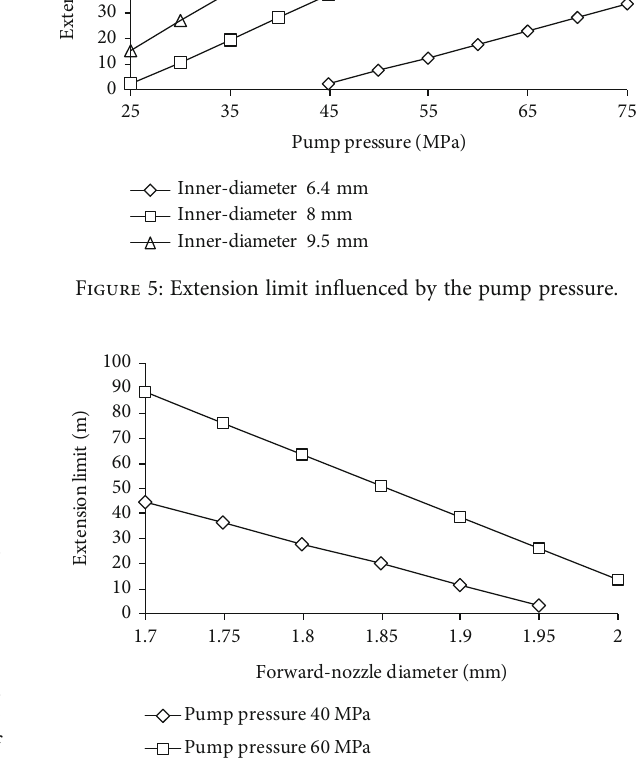
Figure 6: Extension limit in fl uenced by the forward nozzle